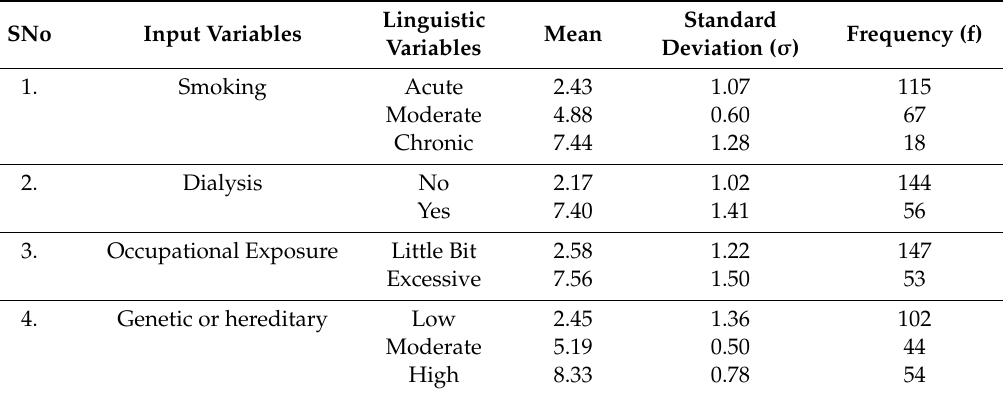
Table 4. Parameter of layer 1.